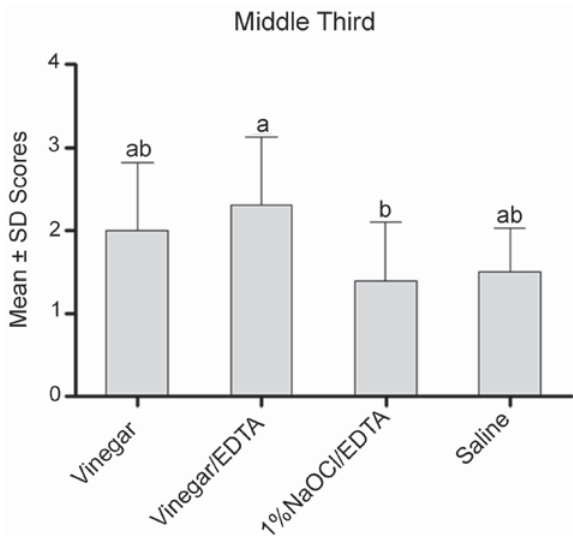
Figure 4- Mean scores±Standard deviation recorded for each group (n=10) in the middle root third. The groups with a different superscript letter are statistically different (p<0.05)